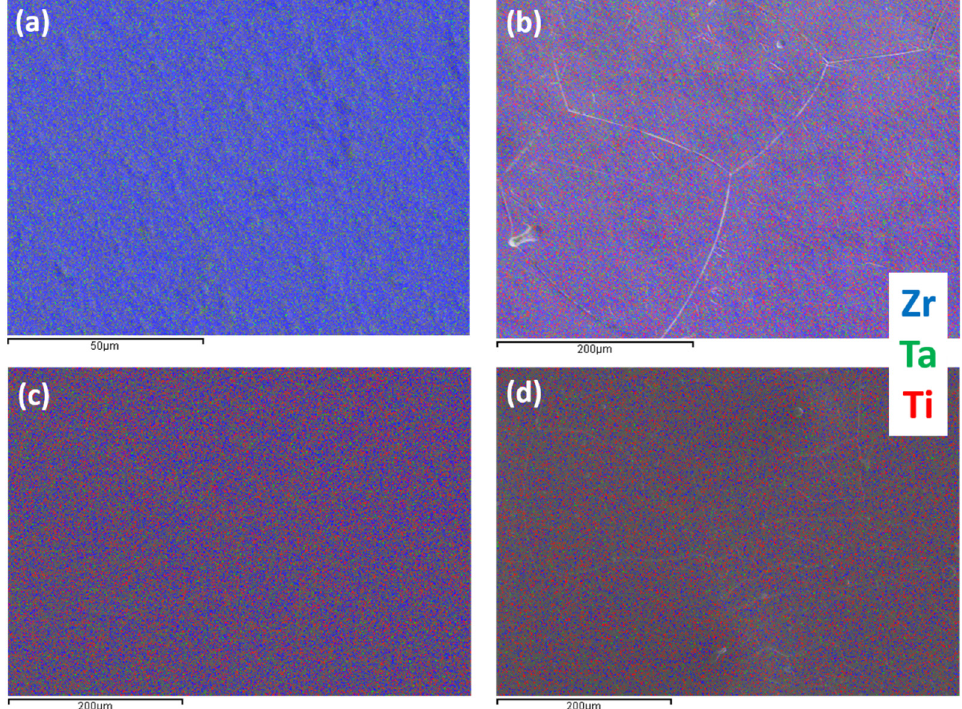
Figure 1. EDS elemental mapping of Zr-25Ta ( a ), Zr-25Ta-15Ti ( b ), Zr-25Ta-25Ti ( c ), and Zr-25Ta-35Ti ( d ) alloys.